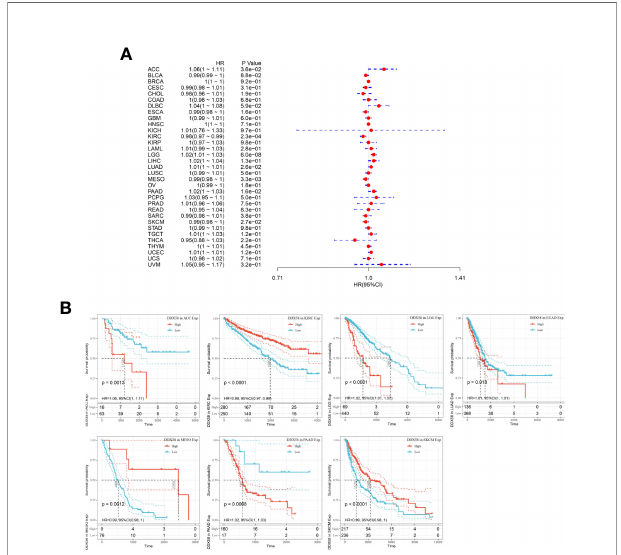
FIGURE 8 | Relationship between DDX58 expression levels and overall survival of patients (A) Forest plot of the risk ratio of DDX58 in human pan- cancer; (B) Kaplan-Meier OS curves of DDX58 in the seven most signi fi cantly associated tumors. Our pan-cancer analysis indicates signi fi cantly higher DDX58 expression in most cancer types than in normal tissues. Our survival analysis suggests that high DDX58 expression is signi fi cantly associated with poor OS, DSS, and PFI in three